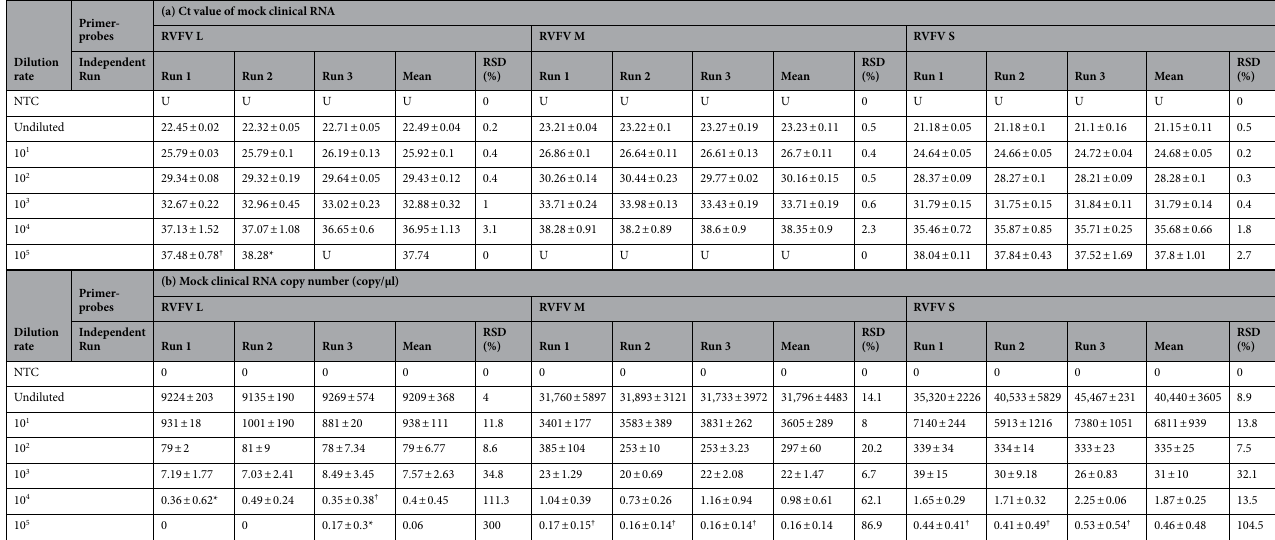
Table 2. Limit of Quantification (LoQ) of the RVFV mock clinical RNA by RT-qPCR with the L, M and S segment assay. (a) Each run represents the mean Ct value of three replicates within an independent run. *Only one of three replicates were positive. † Only two of three replicates were positive. The ‘U’ indicates underdetermined. (b) Each run represents the mean copy number of three replicates within an independent